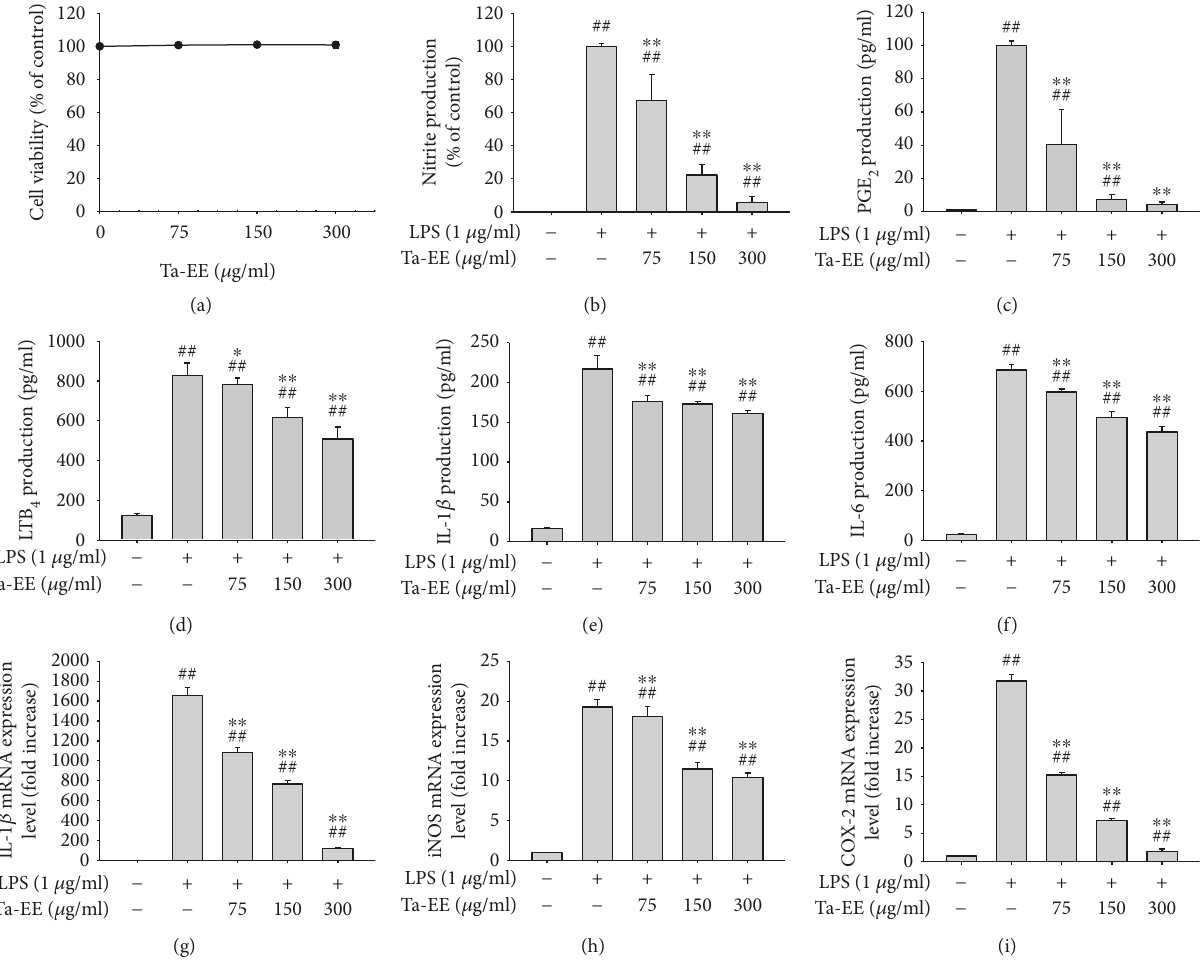
Figure 3: Ta-EE suppressed the production and mRNA expressions of in fl ammatory mediators and proin fl ammatory cytokines in LPS- stimulated RAW264.7 cells. (a) RAW264.7 cells were treated with Ta-EE (0 – 300 μ g/ml) for 24h, and cell viability was measured by MTT assay. (b) RAW264.7 cells pretreated with Ta-EE (0 – 300 μ g/ml) for 30 min were treated with LPS (1 μ g/ml) for 24h, and nitrite production levels in the cell culture media were measured using Griess reagents. RAW264.7 cells pretreated with Ta-EE (0 – 300 μ g/ml) for 30min were treated with LPS (1 μ g/ml) for 24h, and the production levels of (c) PGE , (d) LTB , (e) IL-1 β , and (f) IL-6 in the cell culture 2 4 media were measured by ELISA. RAW264.7 cells pretreated with Ta-EE (0 – 300 μ g/ml) for 30min were treated with LPS (1 μ g/ml) for 6h, and the mRNA expression levels of (g) IL-1 β , (h) IL-6, and (i) COX-2 in the cells were measured by quantitative real-time PCR. ∗ P < 0 05 and ∗∗ P < 0 005 versus a control group; # P < 0 05 and ## P < 0 005 versus a normal